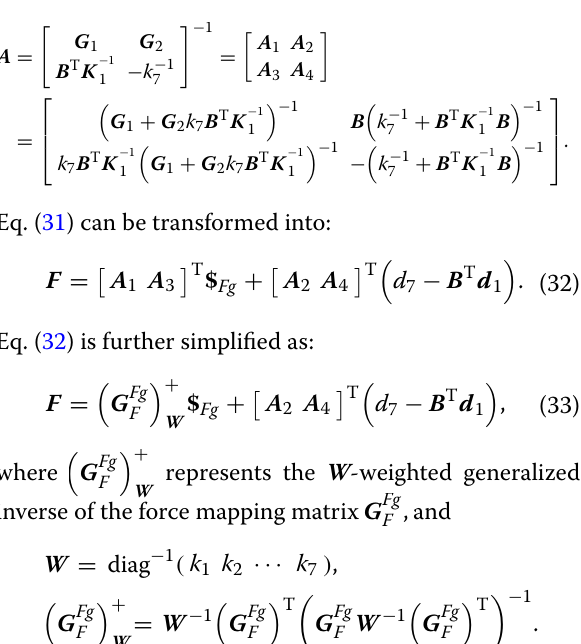
source is passive spring deformation, with parameters k 1 and k 2 representing the non-redundant and redundant limb stiffnesses. The output displacement of the actuation, i.e., the deformation of the spring, is denoted as x 1 and x 2 , respectively. If initial compression of the spring is equal to x 10 and x 20 , and the displacement of the moving platform